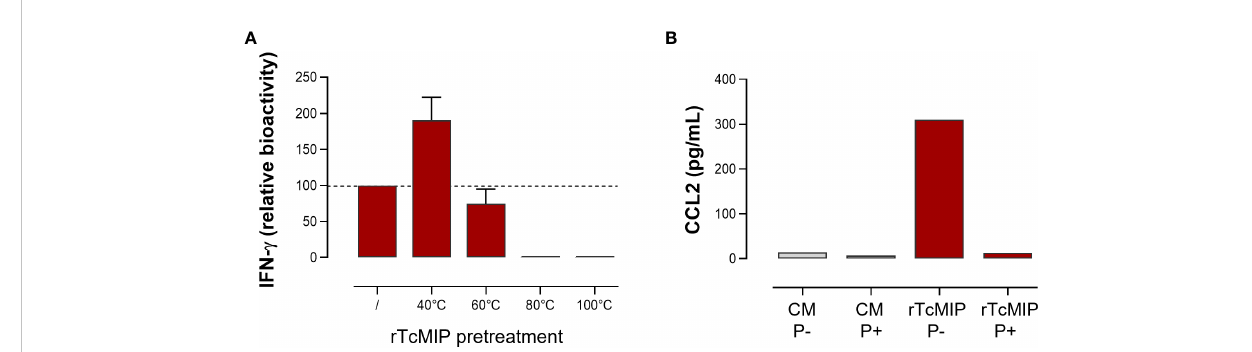
FIGURE 6 Effect of temperature and protease treatment on the bioactivity of rTcMIP. Whole cord blood samples (ten-fold diluted) were incubated with rTcMIP during 24h for CCL2 response or 72h in the presence IL-2 (5 U/mL) and IL-18 (10 ng/mL) for IFN- g response. CCL2 and IFN- g were measured by ELISA in the supernatants. (A) IFN- g response to rTcMIP (5 µg/mL) pretreated by heating during 30 min at the indicated temperatures. Results are expressed as % of the bioactivity of unheated rTcMIP (n=3). (B) CCL2 response to rTcMIP in the presence (P+) or not (P-) of proteases from Streptomyces griseus at 1 µg/mL in the culture medium.